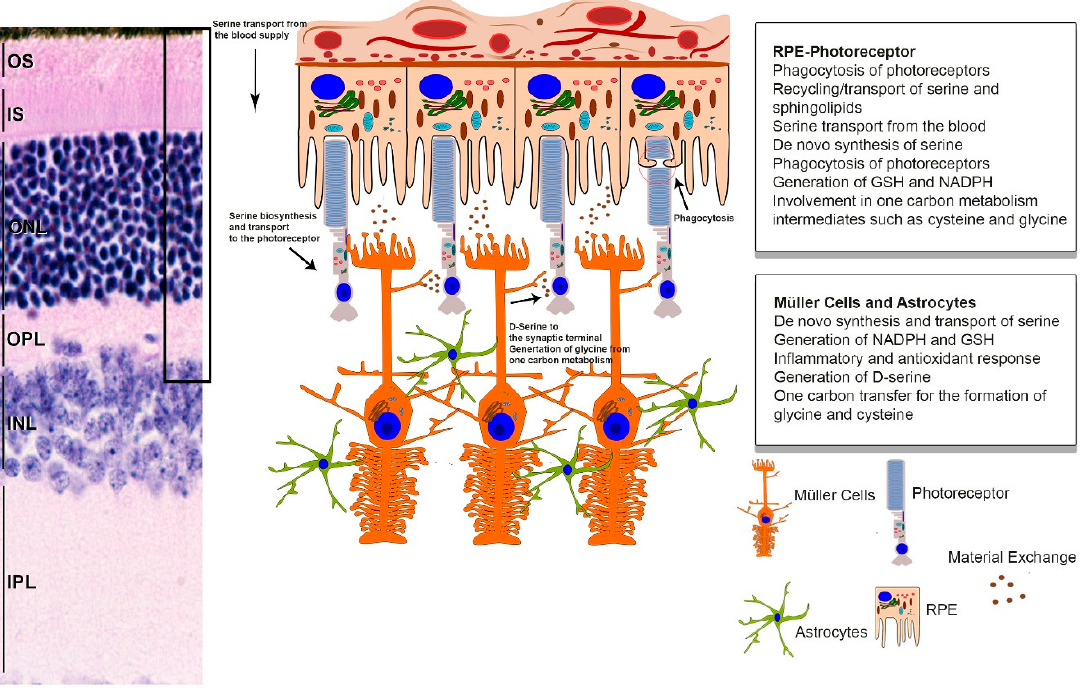
Figure 3. Graphical summary of serine metabolism in the retina. Serine homeostasis is primarily maintained by the RPE and retinal glia. The RPE transports and generates serine, which is ultimately transported to the photoreceptors. Additionally, important serine metabolic products such as glycine and cysteine are transported or catabolized to be used as fuel, as the energetic requirements of the RPE are very high. Photoreceptors also receive serine from the Müller glia and astrocytes. Glial cells are vital to the macula and generate serine from glycolysis, which is crucial in maintaining the redox balance in the photoreceptors, controlling neurotransmission, and mediating inflammation response elements. (IS, inner segment; OS, outer segment; ONL, outer nuclear layer; OPL, outer plexiform layer; INL, inner nuclear layer; IPL, inner plexiform layer).